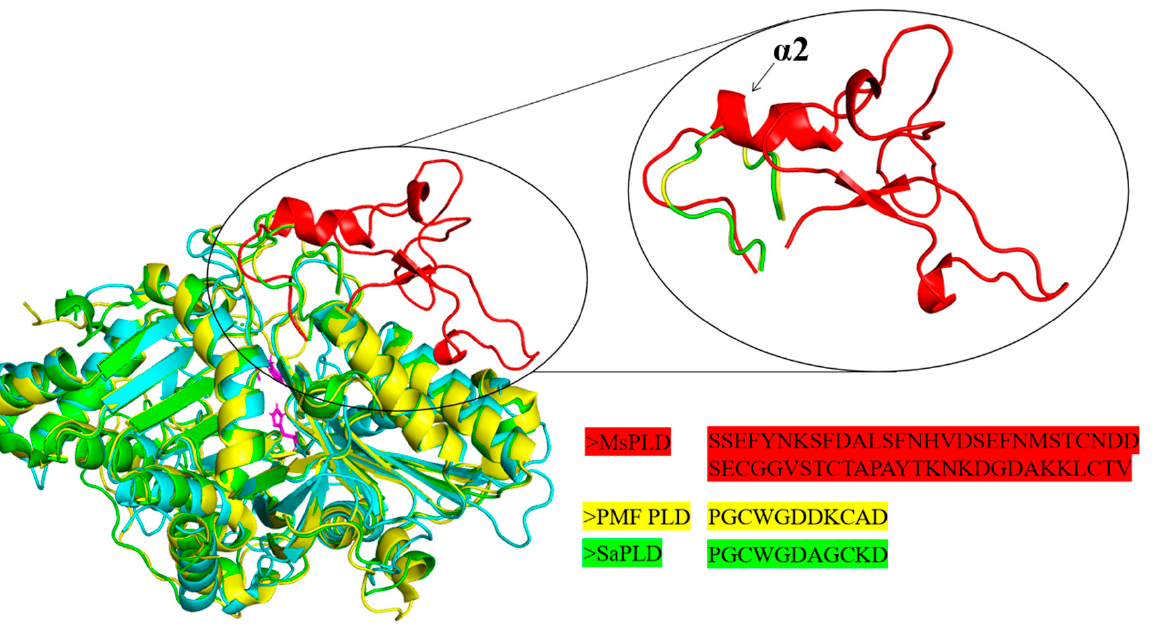
Figure 3. Superimposition and comparison of the structure of MsPLD (cyans, PDB ID: 7WU1) with other Streptomyces PLDs. Streptomyces sp. PMF PLD (yellow, PDB ID: 1F0I), SaPLD (green, PDB ID: 2ZE4). Two catalytic sites and the extra loop of MsPLD are shown in purple sticks and red color, respectively. The enlarged circle shows the unique extra loop motif that exists in MsPLD. The amino acids sequences that composed the corresponding loop are shown underneath.